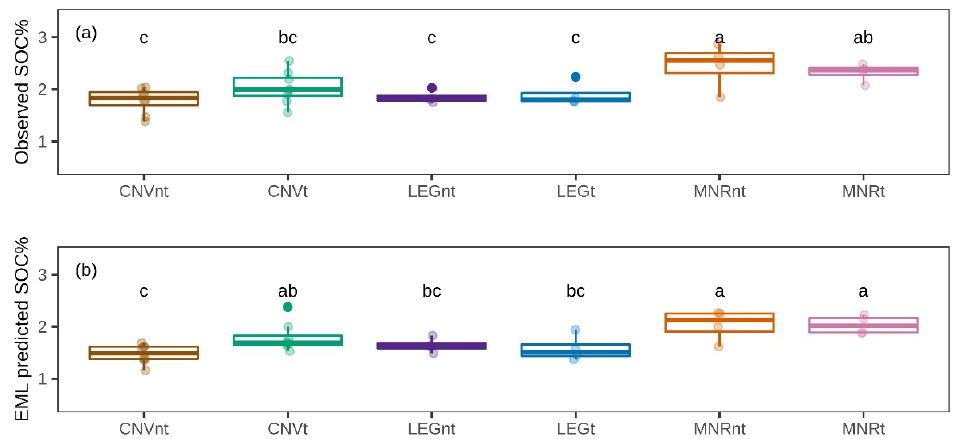
Figure 3. Box plots of observed ( a ) and EML predicted ( b ) SOC% for the 2015 Rodale trials. Test across similar management but with till vs no-till. t-test comparison, No significant difference between the same letters. Significance level <0.05. Sample size per treatment, CNVnt, CNVt n = 8 each, LEGnt, LEGt, MNRnt, MNRt n = 4 each (total 32).